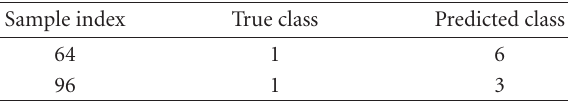
Table 4. Misclassifications of lymphoma.